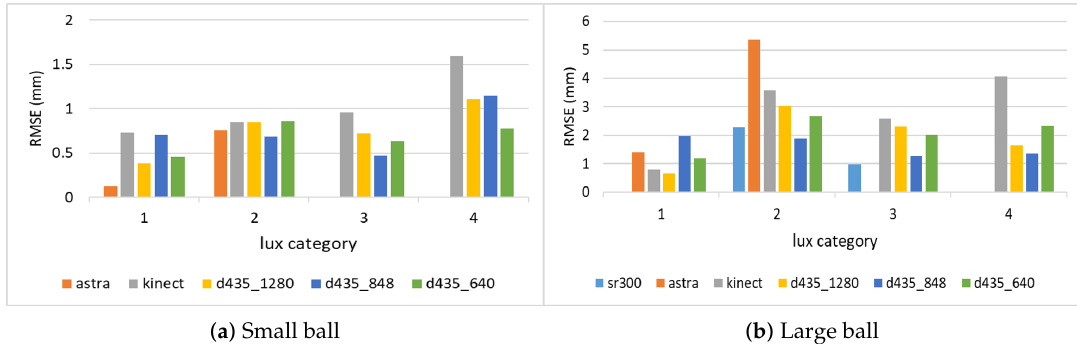
Figure 10. RMSE for diameter estimation of the two balls in varying light intensity categories.